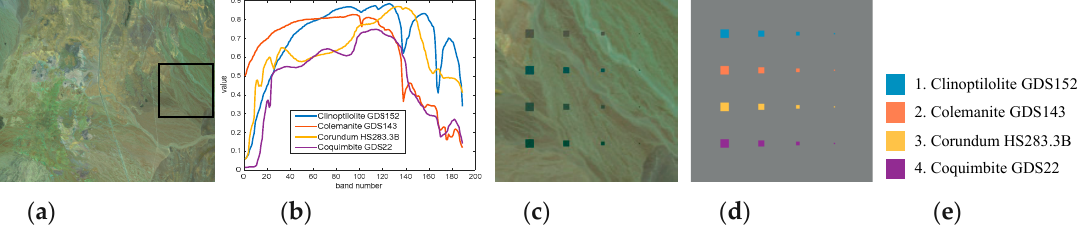
Figure 19. ( a ) The false color sense of Cuprite data (bands 160, 100, 40). ( b ) The spectra used to construct targets. ( c ) the synthetic data. ( d ) The ground truth. ( e ) The legend of different targets.